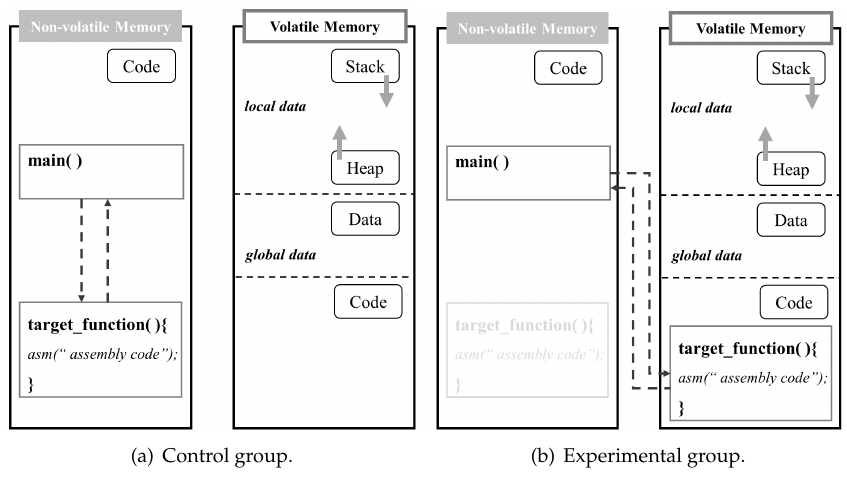
Figure 5. Code relocation scheme using assembly code injection technique.